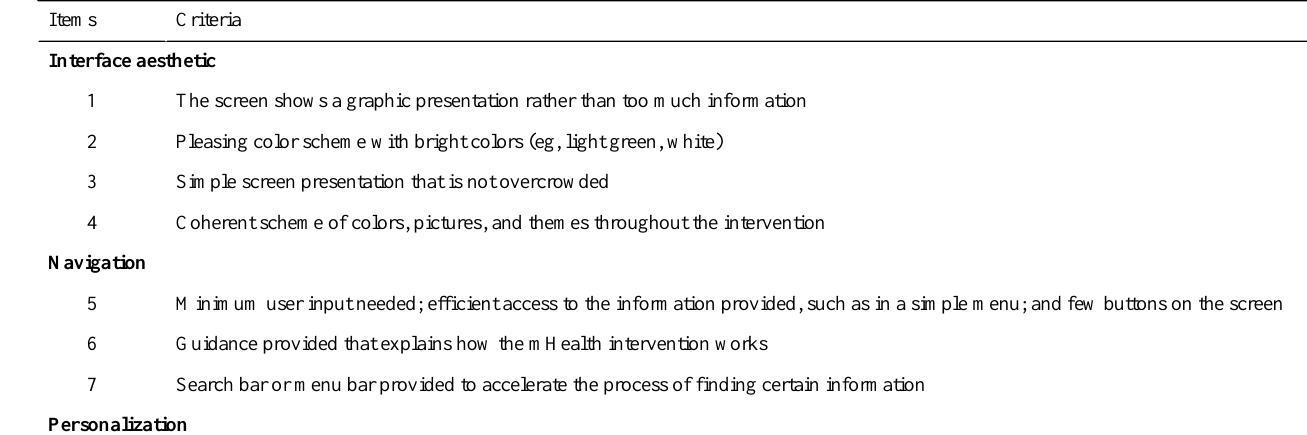
Table 1. Checklist of design features that enhance user engagement.